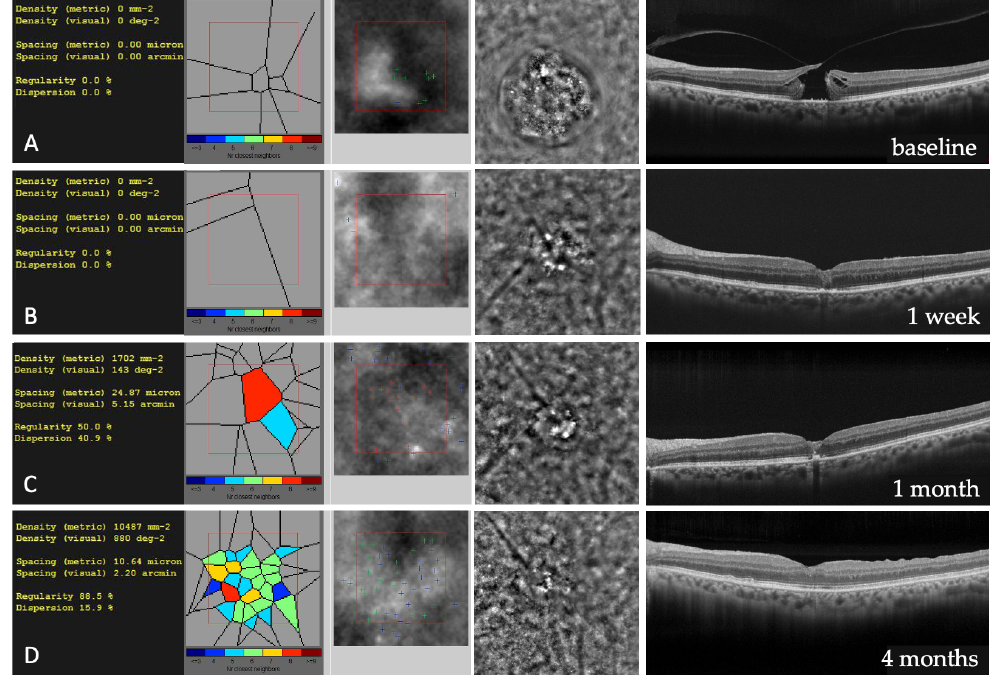
Figure 10. ( A – D ) Adaptive Optics images of cone mosaic (on the left part of the figure), with the estimation of cone density, in a full-thickness macular hole before and after surgery at different time points. Optical Coherence Tomography scans corresponding to the different adaptive optics images are depicted in the right part of the image.